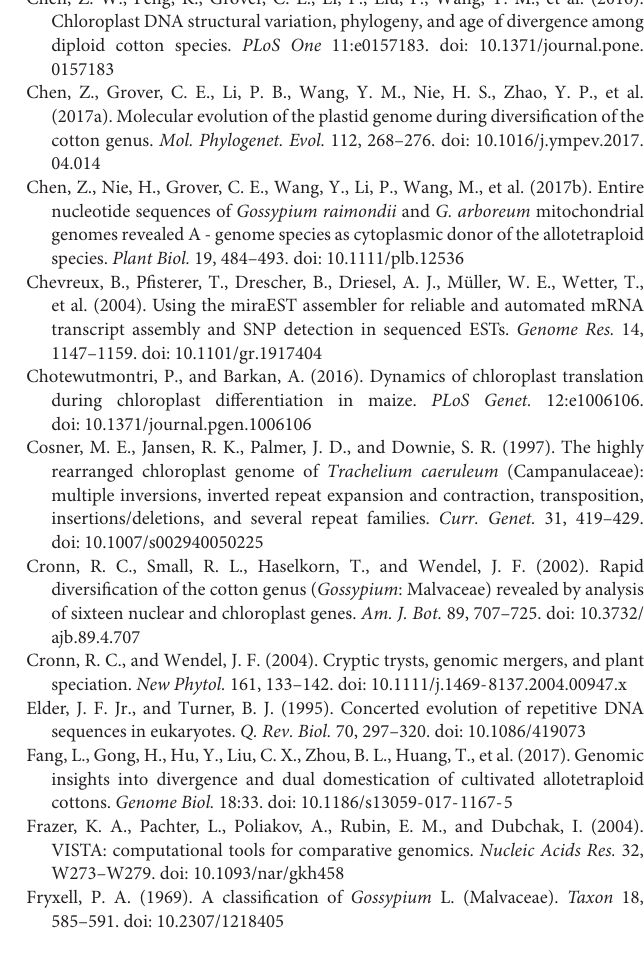
TABLE S6 | Distribution of tandem repeat lengths in cotton species. TABLE S7 | Distribution of SSRs in cotton chloroplast